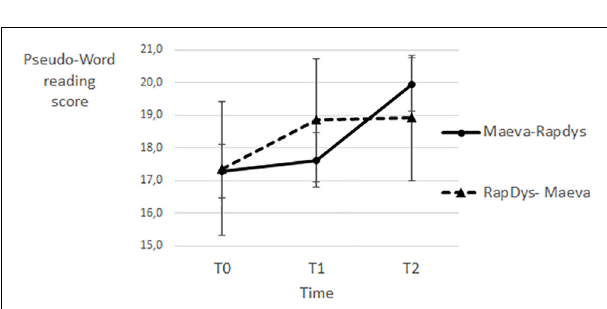
FIGURE 7 | Regular word reading scores for each time period and each presentation order.